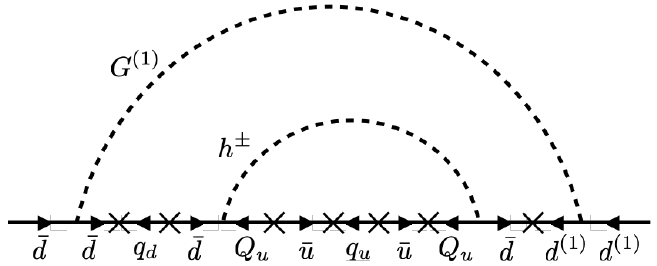
Figure 4 . A two-loop diagram which contains the first KK excitation mode of the down-type quark d (1) (the Dirac partner of ¯ d (1) ). The flavor indices are also omitted. of ¯ d (1) ). This diagram also includes η ¯ d (1)